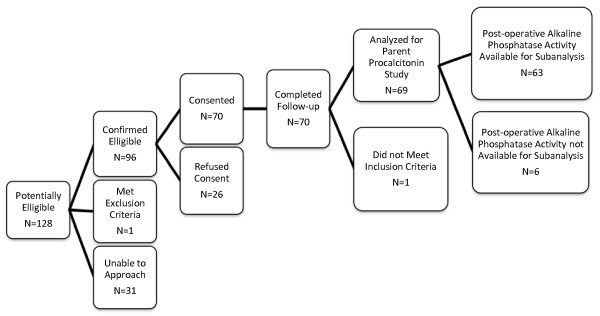
Patient enrollment flow chart.